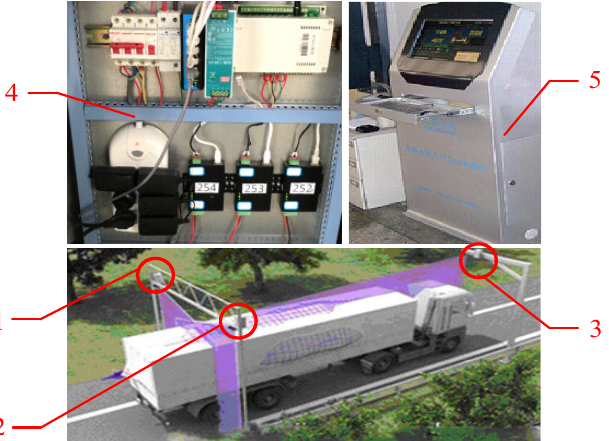
Figure 1. Structure of the proposed system. 1—Left lidar 2—Right lidar 3—Front lidar 4—Control box 5—Industry controlling computer.